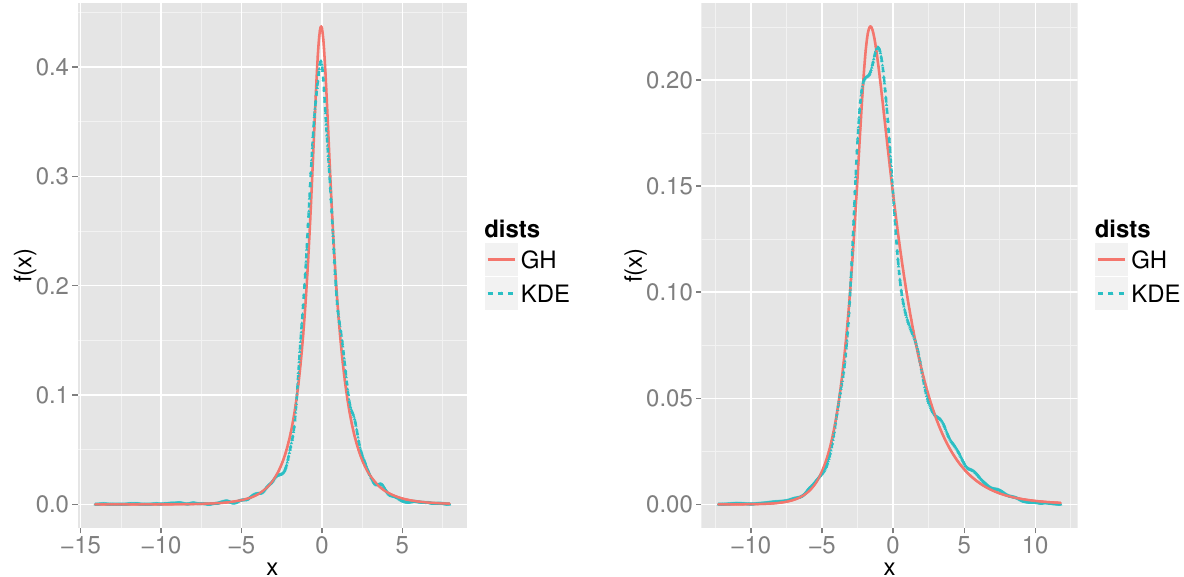
Figure 2. We plot estimated probability density functions (pdf) of the regression errors of the overconstrained L 2 Markov Tree method applied to the SPX09 (left) and SPX10 (right) data sets. Solid (red) curves show kernel density estimates (KDE), and dashed (blue) curves show the generalized hyperbolic (GH) pdf using the best fit parameters from Table